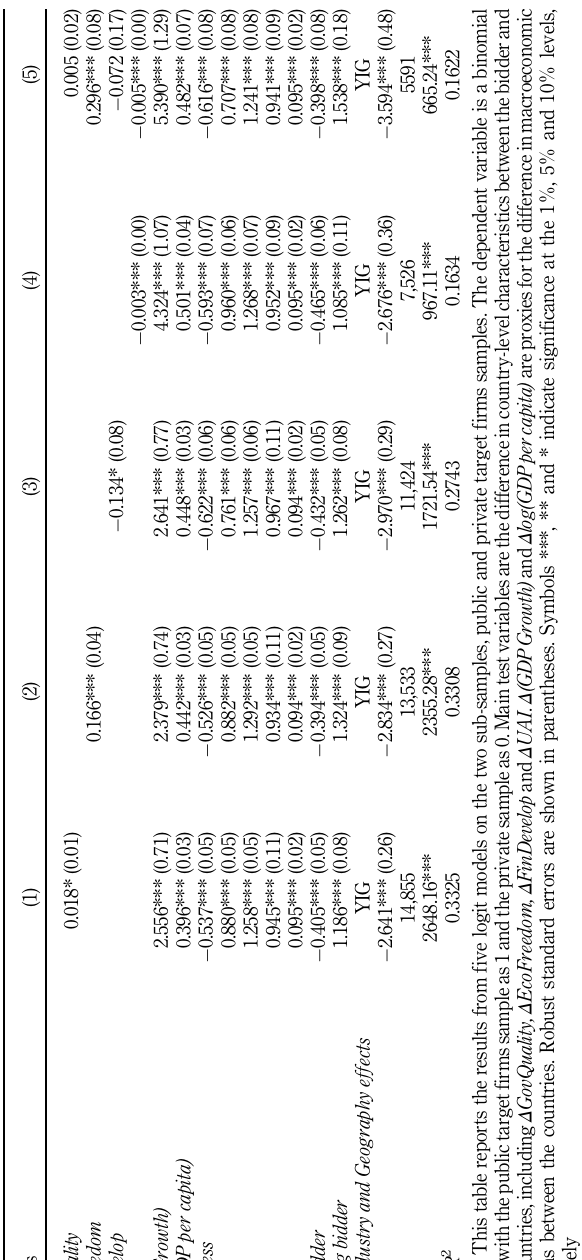
Table 5. Robustness on cross- country determinants of target status choices using the difference independent